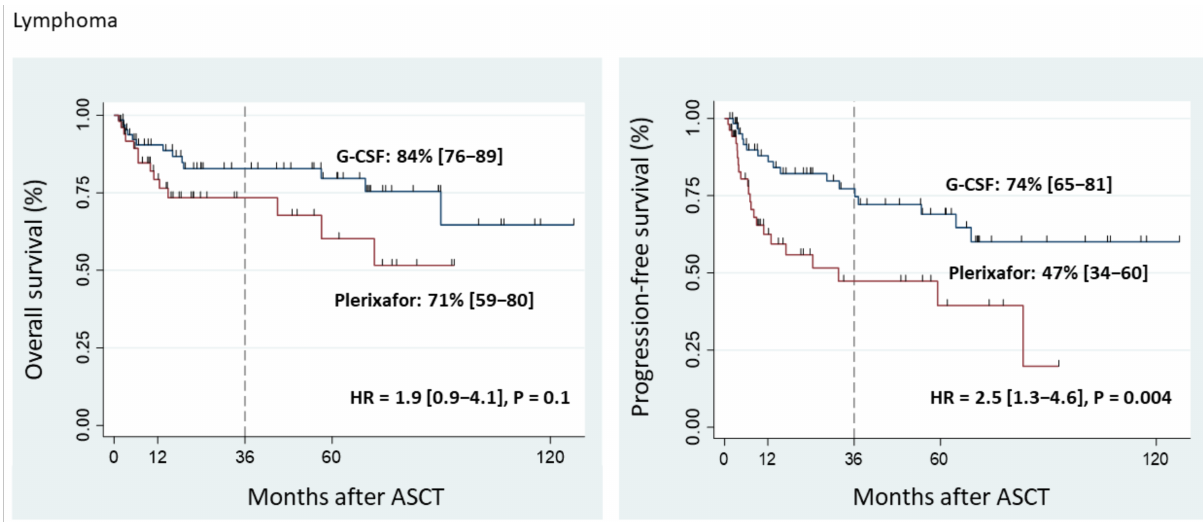
Figure 2. Overall survival and progression-free survival of lymphoma patients. The 3-year PFS in lymphoma patients mobilized with Plerixafor was 47% (95% CI, 34–60%) vs. 74% (95% CI, 65–81%) in the G-CSF Group ( p = 0.003) (Figure 2). During the observation period, eight myeloma patients (4%, four in each cohort; Plerixafor Group: one melanoma, one prostate cancer, one lung adenocarcinoma, one renal cell carcinoma; G-CSF Group: one Hodgkin’s lymphoma, two melanomas, and one t-AML) and six (5%) lymphoma patients developed a secondary malignancy after ASCT (five in the Plerixafor Group: one non-small-cell lung carcinoma, one myelodysplastic syndrome, three other lymphomas, and one in the G-CSF Group with a myeloproliferative neoplasm) (Tables 3 and